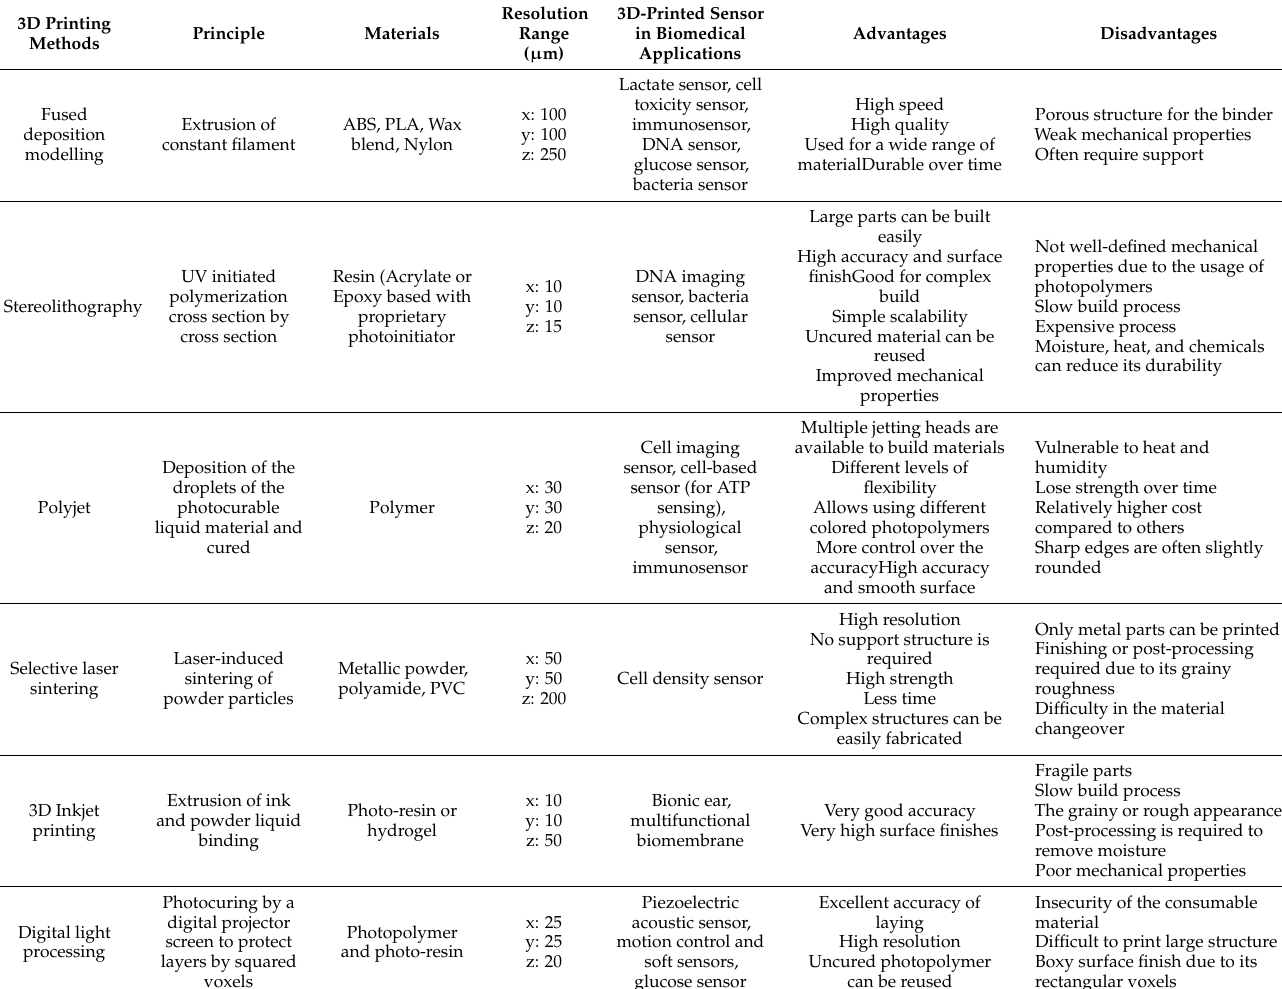
Table 2. A summary of Additive Manufacturing (AM) techniques: principle, materials, resolution and 3DP sensors in biomedical applications (Based on Reference